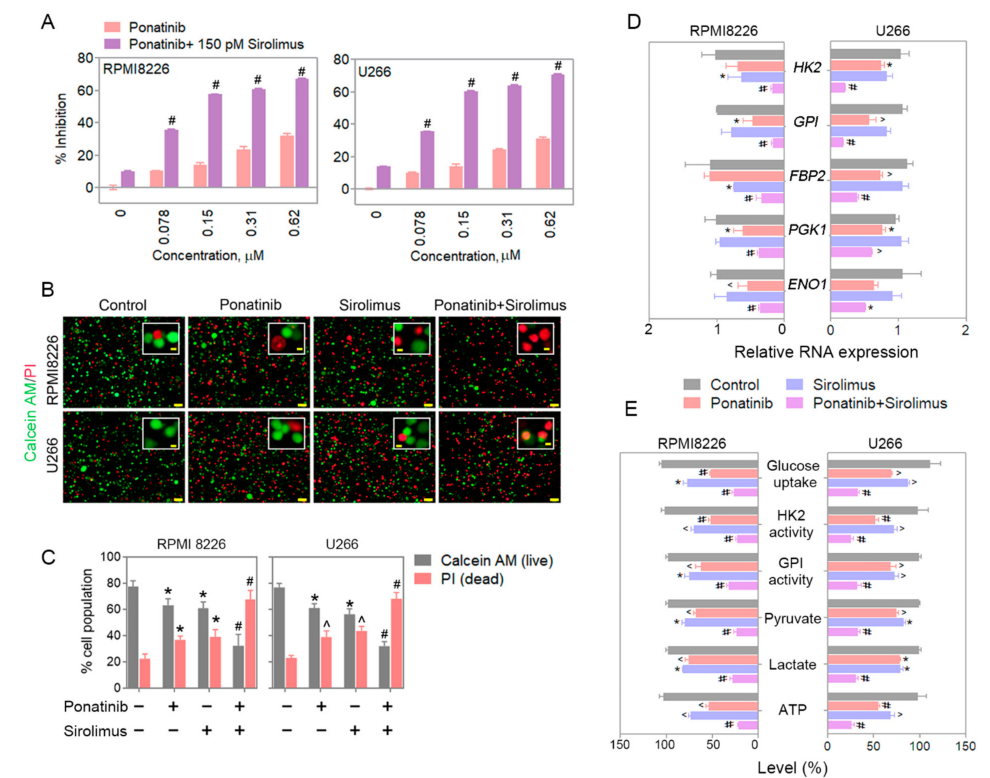
Figure 3. Sirolimus potentiates ponatinib-mediated glycolysis inhibition and induces multiple myeloma cell death. ( A ) Metabolic assay was performed on RPMI8226 and U266 cells in the pres- ence of variable doses of ponatinib alone or with 150 pM sirolimus. The histograms represent the inhibition percentages; treatment was for 72 h. Sirolimus at 150 pM potentiates the ponatinib inhi- bition on metabolic activity significantly. ( B ) Calcein AM and PI staining show a combination of ponatinib and sirolimus significantly increases the dead cell population in the cultures of MM cells. ( C ) Quantification for Calcein AM and PI-positive cell populations. Cells were counted by using ImageJ software and plotted as histograms, using GraphPad Prism 5 software. Scale bars for the large field are 50 µ m; those for the magnified inset are 5 µ m. ( D ) RPMI8226 and U266 cells were treated with ponatinib and/or sirolimus for 12 h. The glycolytic gene-expression changes were examined by qPCR. ( E ) RPMI8226 and U266 cells were treated with ponatinib and/or sirolimus for 24 h. The HK2 and GPI activity was measured by activity assay kits. Glucose, ATP, lactate, and pyruvate levels were quantified by specific assay kits. Doses used for ponatinib and sirolimus were 300 nM and 150 pM, respectively. Data are presented as mean ± SEM; t -test: * p < 0.05, ˆ p < 0.01, and # p <